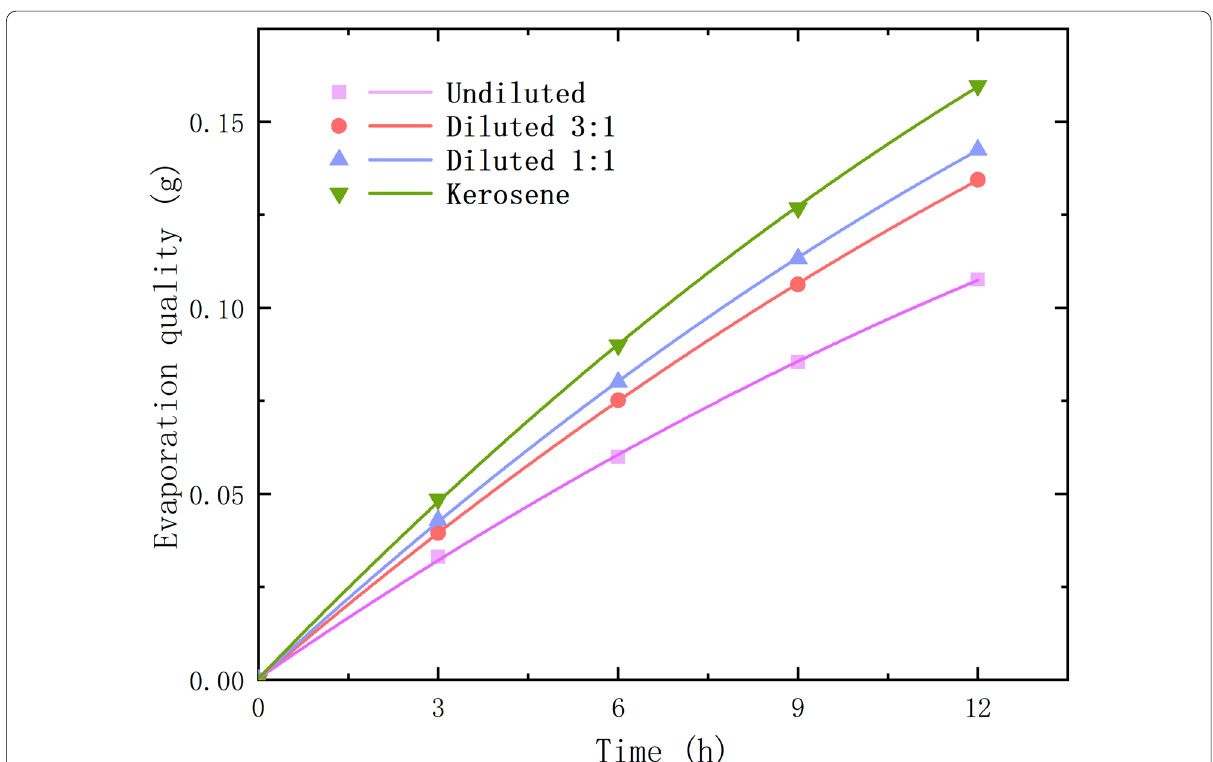
Figure 6 Weight loss of samples and their fitted curves with different dilution